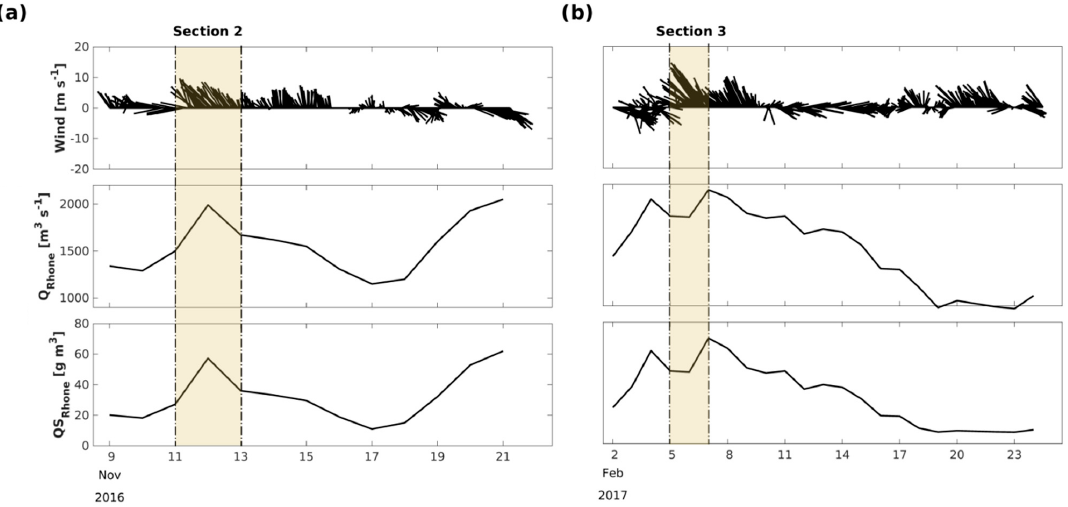
Figure 5. Time-series of atmospheric conditions at Cap-Couronne station (40°20.23 ′ N; 5°01.38 ′ E) for ( a ) autumnal and ( b ) winter conditions. Black lines correspond to hourly (10-min burst average) wind speed and direction. By convention, wind direction indicates its origin. The shaded area corresponds to the sections chosen to illustrate hydrological, hydrodynamical, and biogeochemical features.